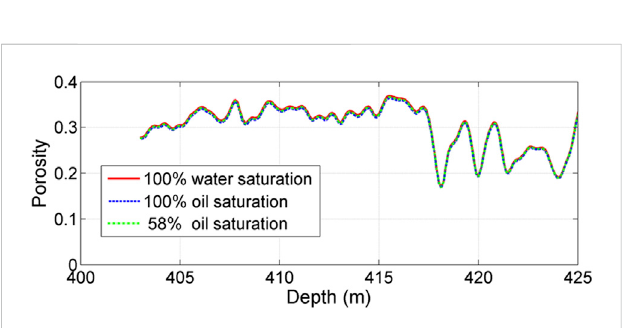
FIGURE 13 Predicted porosity logs under the cases of different oil